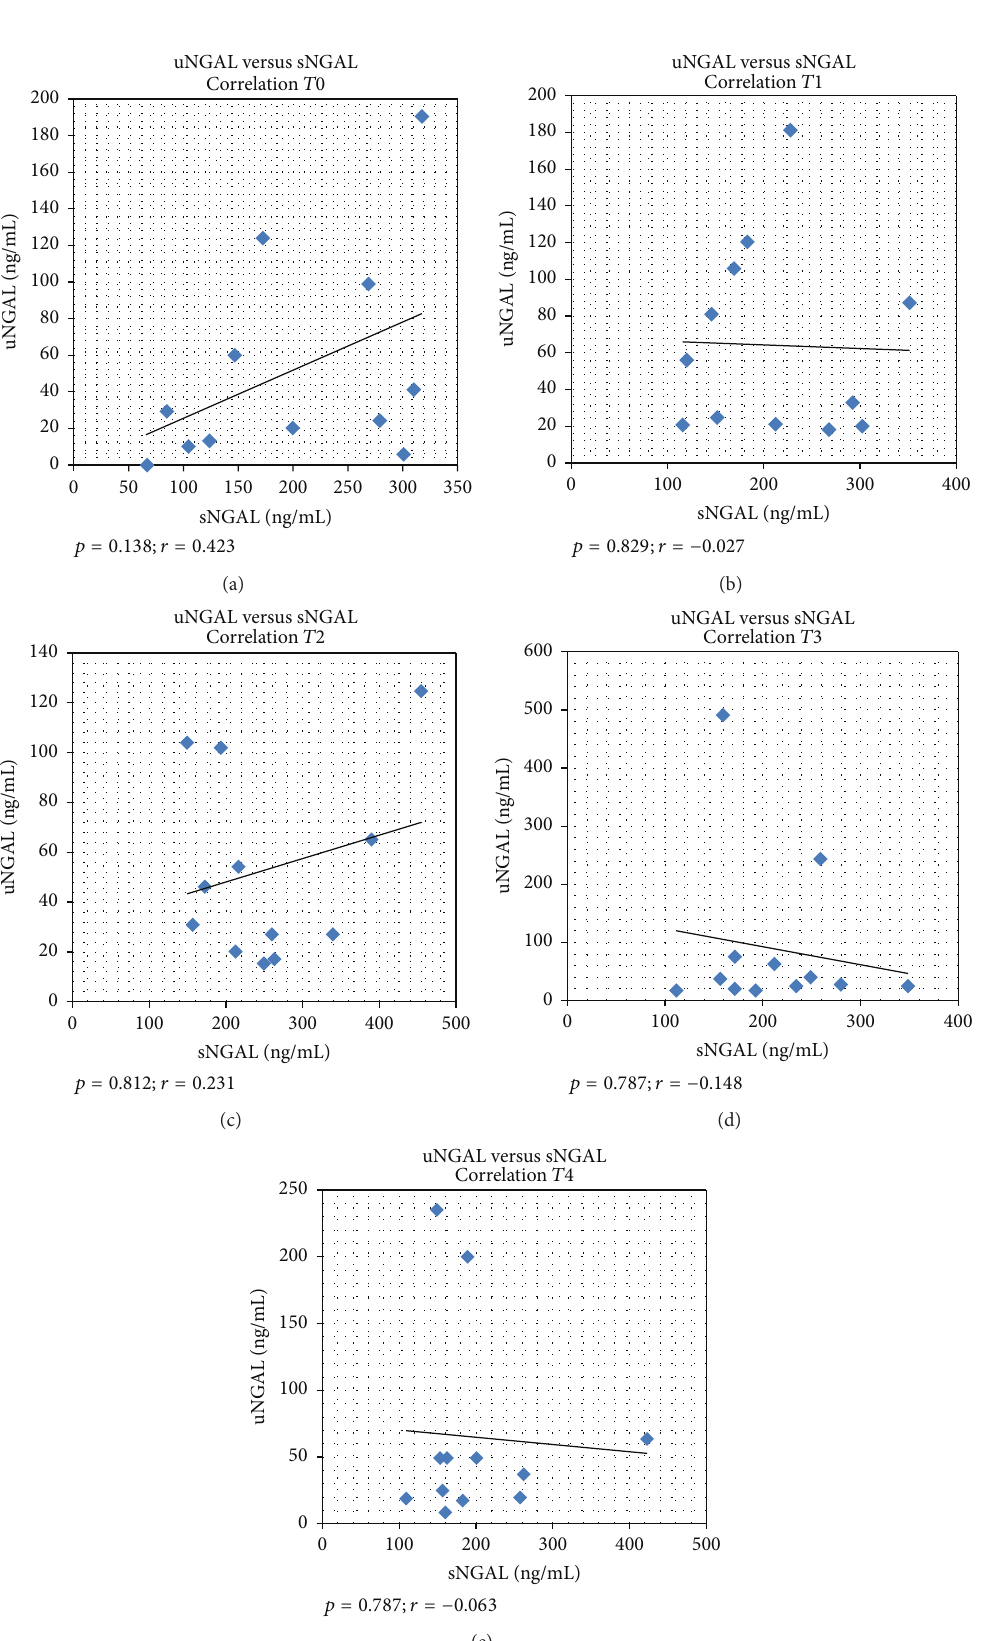
Figure 4: Rank-correlation of uNGAL with paired pNGAL values in the patients population. 𝑝 = statistical significance; r = rank correlation